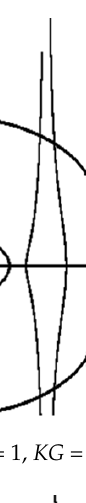
Figure 11. q = 1, KG = 120, and DK = 120.